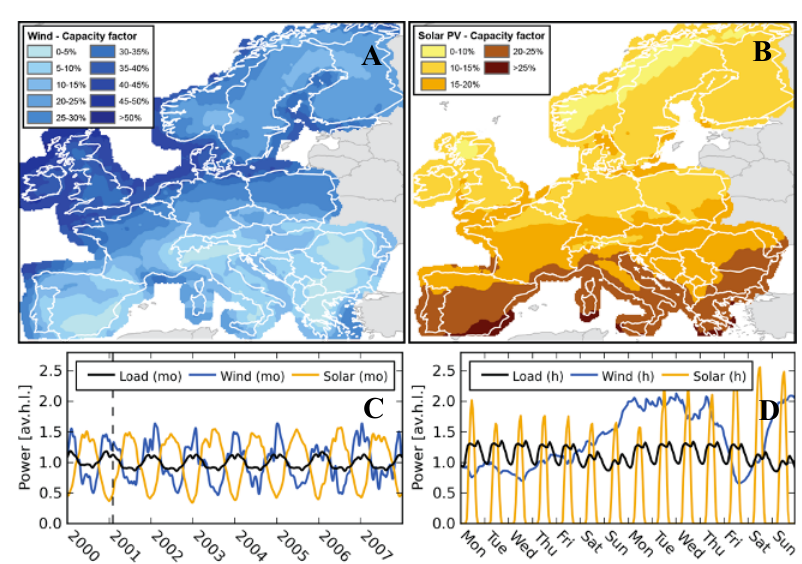
Fig. 1. Wind and solar power generation is derived from historical weather Panels A and B illustrate the geographical extend of the data. In colour we show: (A) average wind power output scaled to installed peak capacity (wind power capacity factor), and (B) average solar PV power output scaled to installed peak capacity (solar PV power capacity factor). Panels C and D show normalized monthly and hourly averages of wind and solar PV power generation and electricity demand aggregated for all 27 countries.